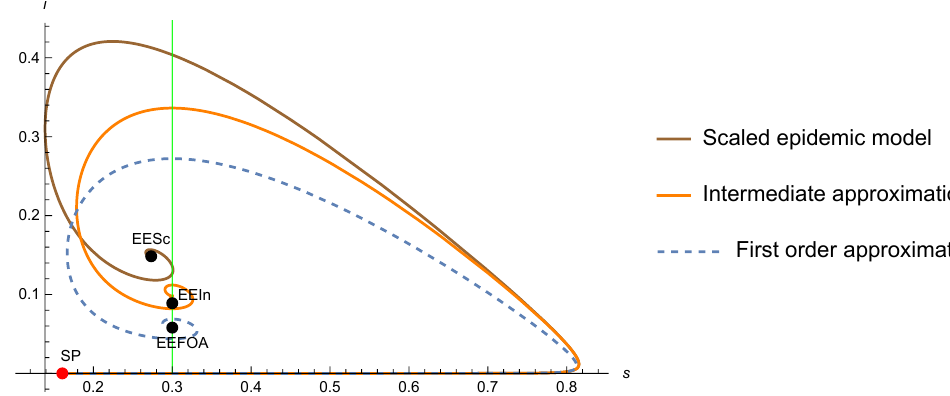
Figure 2. Parametric ( s , i ) plots of the scaled epidemic and its FA and intermediate approximations for a SIR-type model with one infectious class, starting from a starting point SP with i 0 = 10 − 6 , with R 0 = 3.21, β = 5, γ = 1/2, Λ = µ = 1/10, γ r = 1/6, γ s = 0.01, ν i = 0.9, ν r = 0. EESc , EEIn , and EEF 0 A are the stable endemic points of the scaled model, IA (intermediate) model, and FA model, respectively. The green vertical line denotes the immunity threshold 1/ R = s EEF 0 A = s EEIn . Note that the epidemic will at first spend a long time (since births and deaths have slow rates as compared to the disease) in the vicinity of the manifold the three processes are indistinguishable, before turning toward the endemic equilibrium